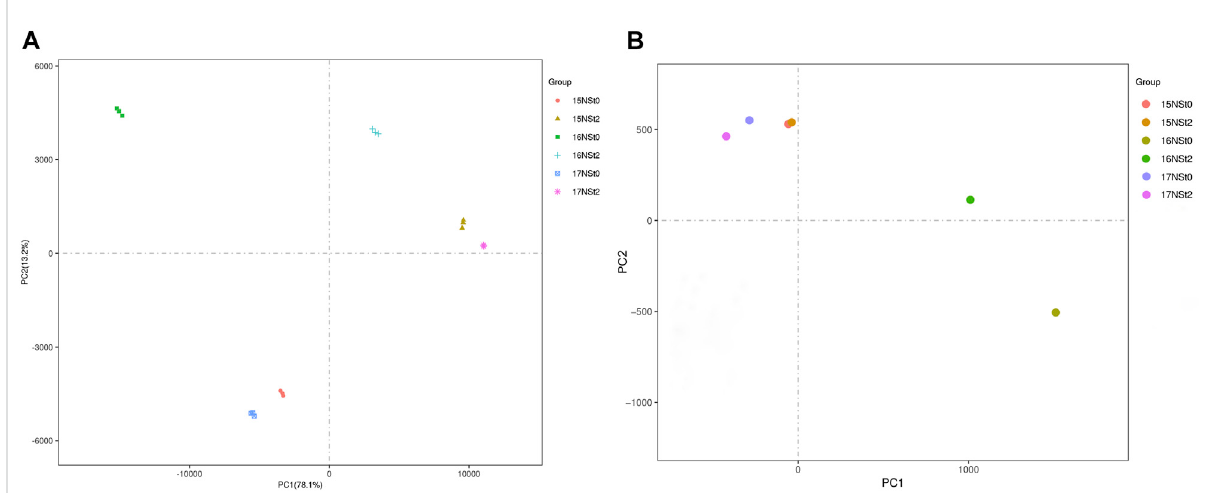
FIGURE 2 PCA maps of transcriptome and methylome in winter rapeseed NS. (A) , PCA of detected genes in RNA sequencing; (B) , PCA of detected methylation sites in whole genome bisul fi te sequencing.